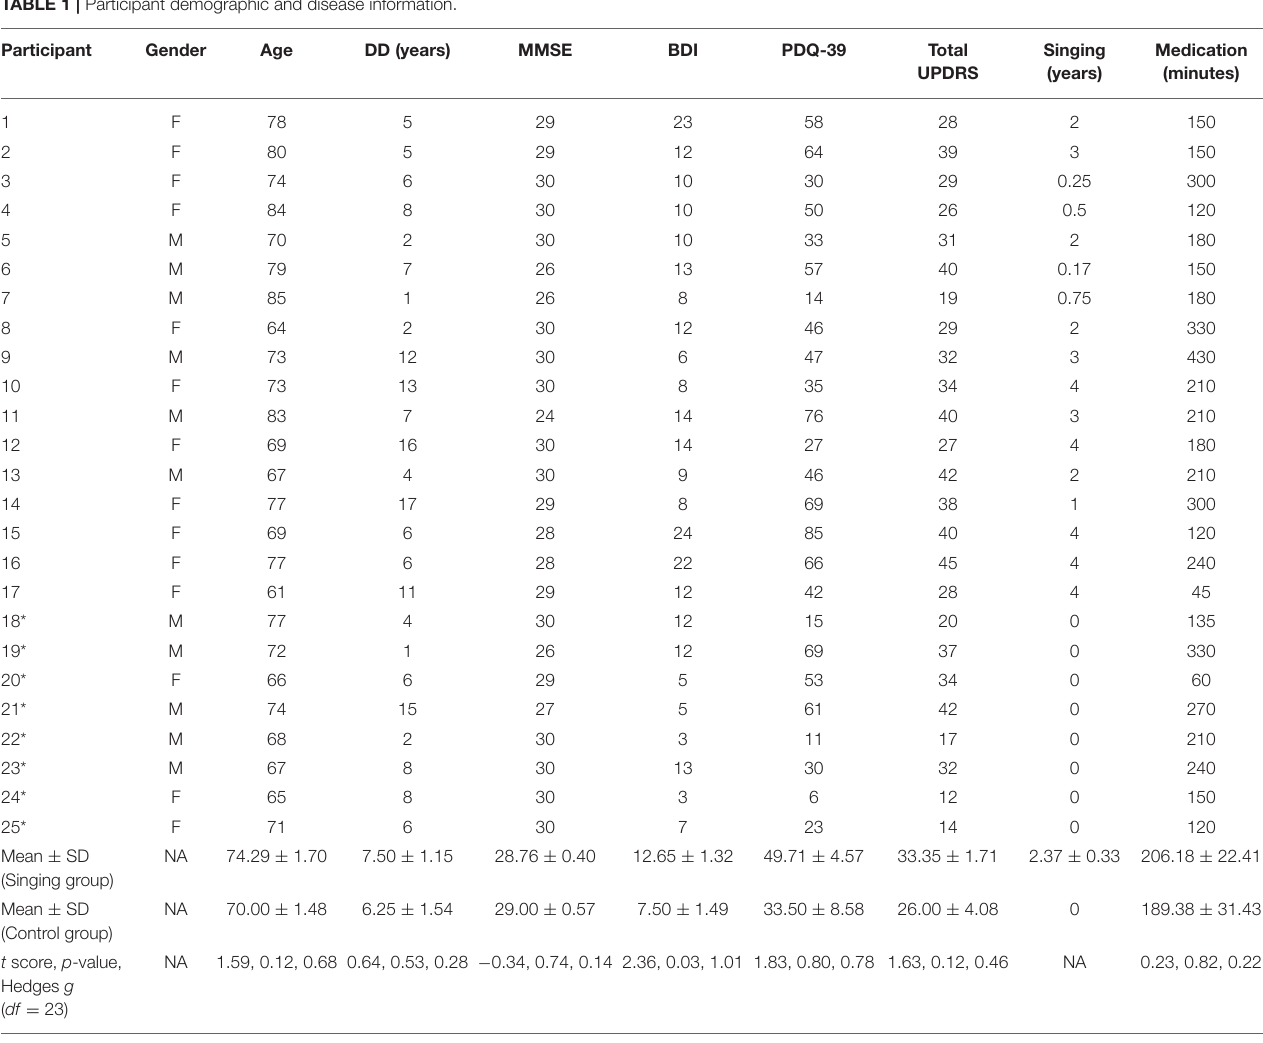
Asterisks designate participants in the control group. Shaded cells indicate significant differences between groups. Medication is time in minutes since last taking their normal PD medication to the start of the singing session. SD, Standard Deviation; DD, Disease Duration; MMSE, Mini Mental State Exam; BDI, Beck Depression Inventory; PDQ-39, Parkinson’s Disease Quality of Life Scale; UPDRS, Unified Parkinson’s Disease Rating Scale; Singing, Number of Years Singing; Medication, Time Since Parkinson’s